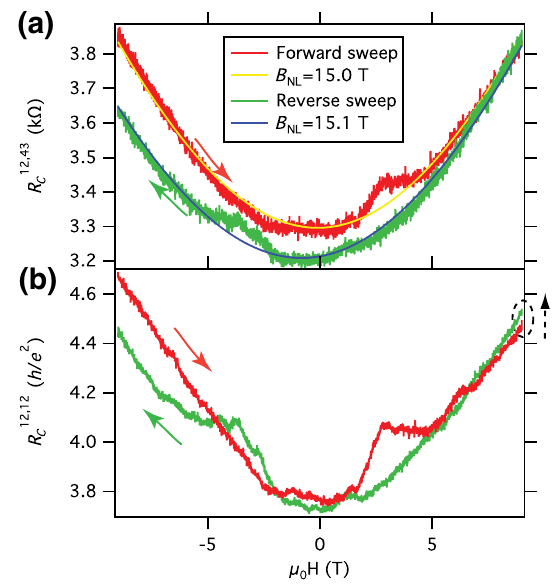
FIG. 2. Out-of-plane field dependence of (a) nonlocal resist- and (b) local two-terminal resistance R 12 ; 12 ance R 12 ; 43 C 4 K . Red and green curves represent forward and reverse sweeps (at 3 mT = s ). Yellow and blue solid lines in (a) are empirical fits q ffiffiffiffiffiffiffiffiffiffiffiffiffiffiffiffiffiffiffiffiffi / þ B 2 B 2 with form R 14 ; 23 , giving two similar built-in fields NL C B of 15.0 T and 15.1 NL